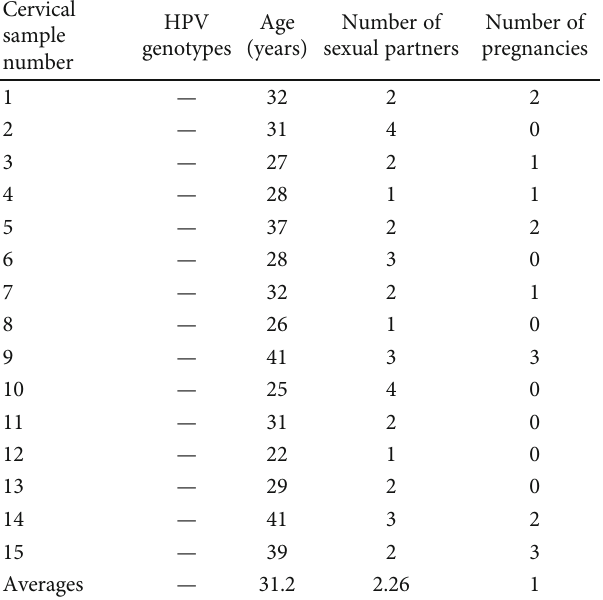
Table 1: Clinical data of normal